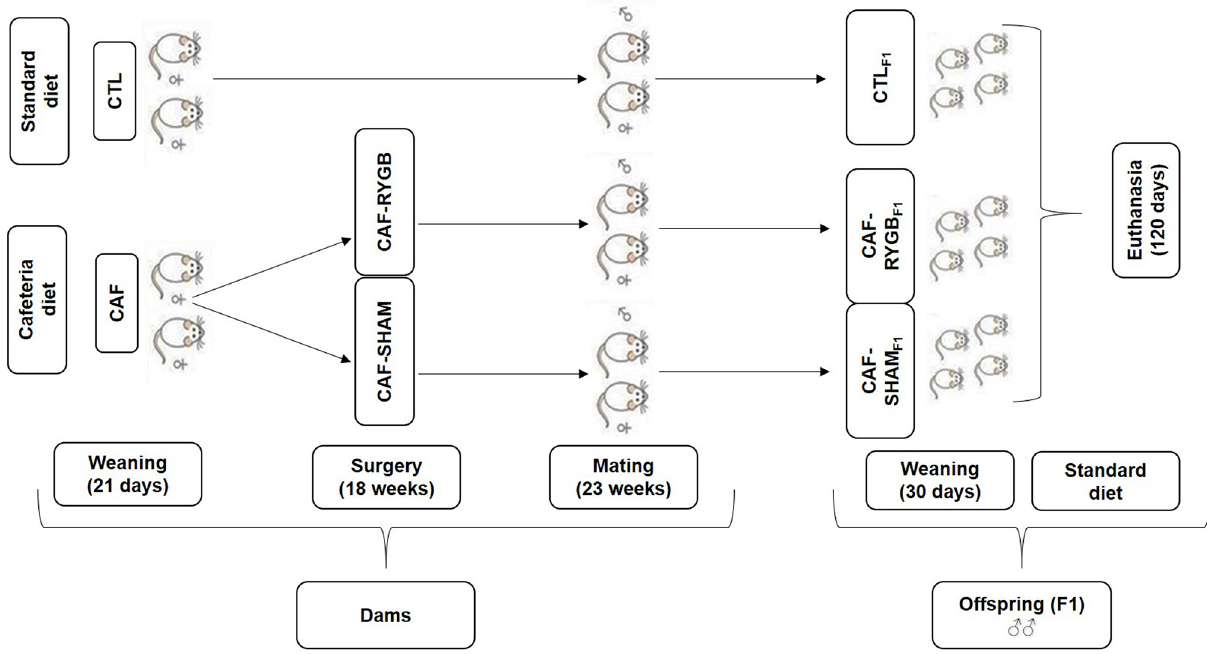
Figure 7. Design of experimental groups. Control Group (CTL), dams received standard diet throughout life (n = 13); Cafeteria Group (CAF), dams received cafeteria diet throughout life (n = 34); Cafeteria Group SHAM (CAF-SHAM; n = 14), dams received cafeteria diet throughout life and were submitted to sham operation; Cafeteria submitted to RYGB (CAF-RYGB; n = 20), dams received cafeteria diet throughout life and were submitted to roux y gastric bypass. Offspring (F1): CTL F1 , offspring of rats fed on standard diet; CAF-SHAM F1 , offspring of rats fed on CAF diet and submitted to sham operation; CAF-RYGB F1 , offspring of rats fed on CAF diet and submitted to RYGB (n = 6–12 rats/groups). ♀ Female; ♂